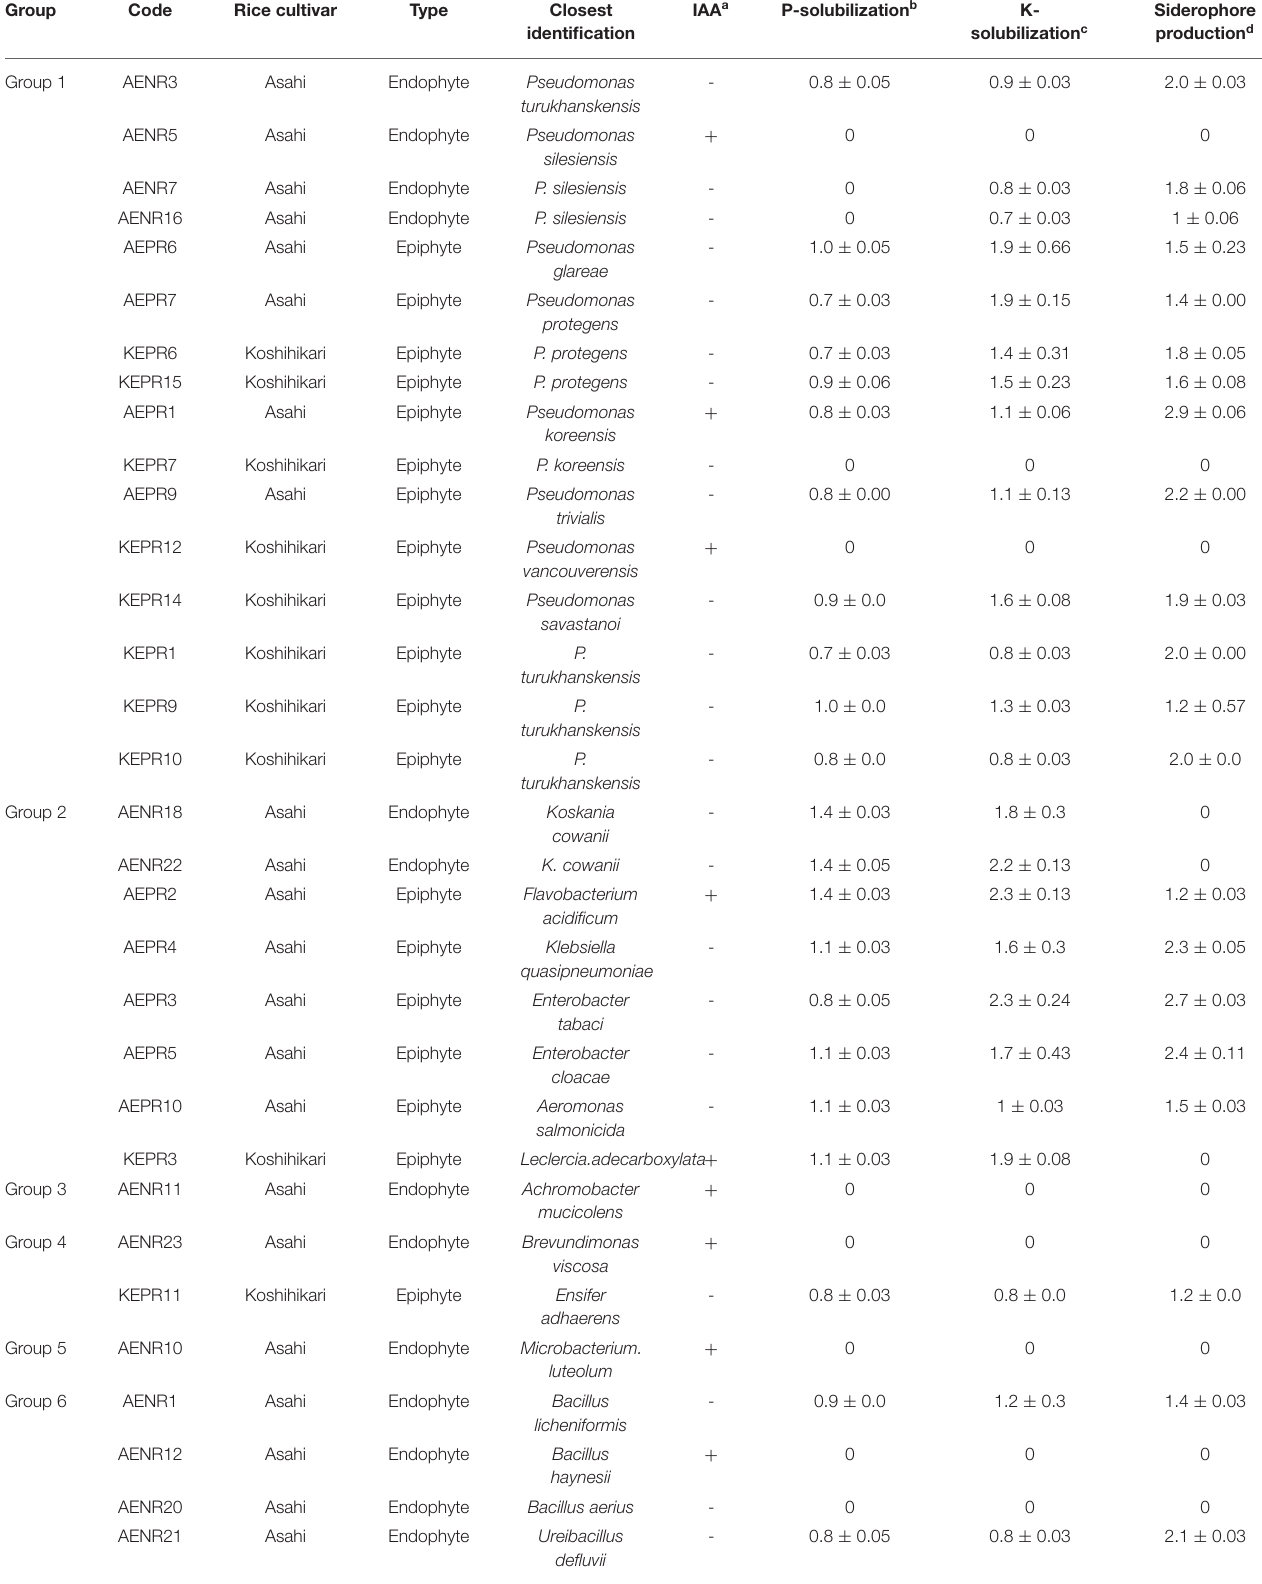
TABLE 1 | Details of isolates, closest relatives, and PGP traits.